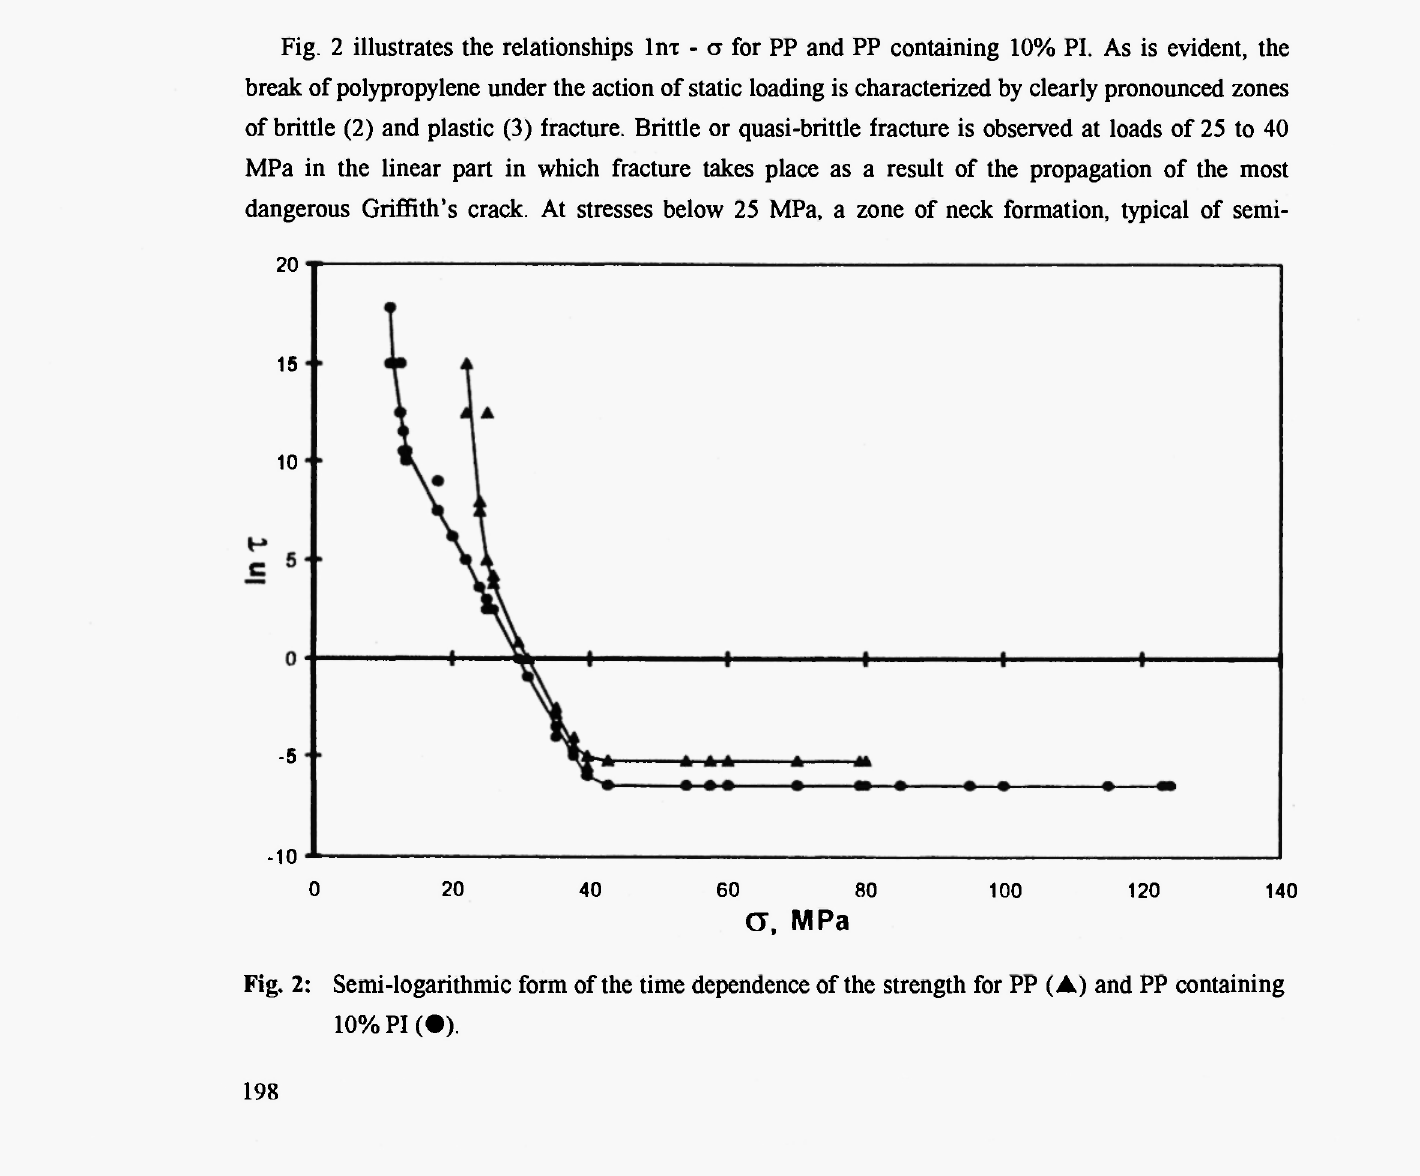
Fig. 2: Semi-logarithmic form of the time dependence of the strength for PP (A) and PP containing